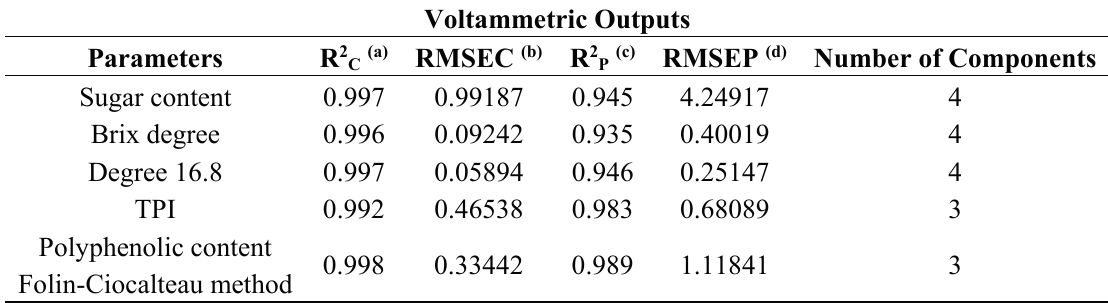
Table 2. Statistical parameters obtained for the N-PLS regression model established between the chemical parameters and the voltammetric responses of the sensors towards musts.